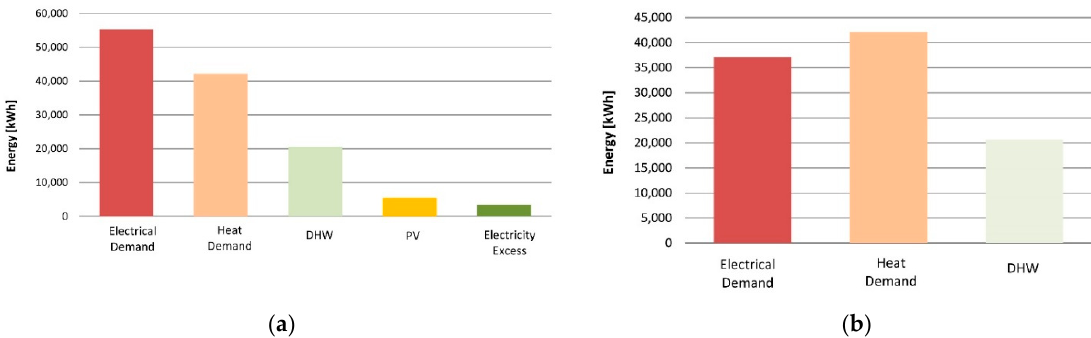
Figure 10. Total energy produced in the hybrid energy system ( a ) and in the traditional energy system ( b )